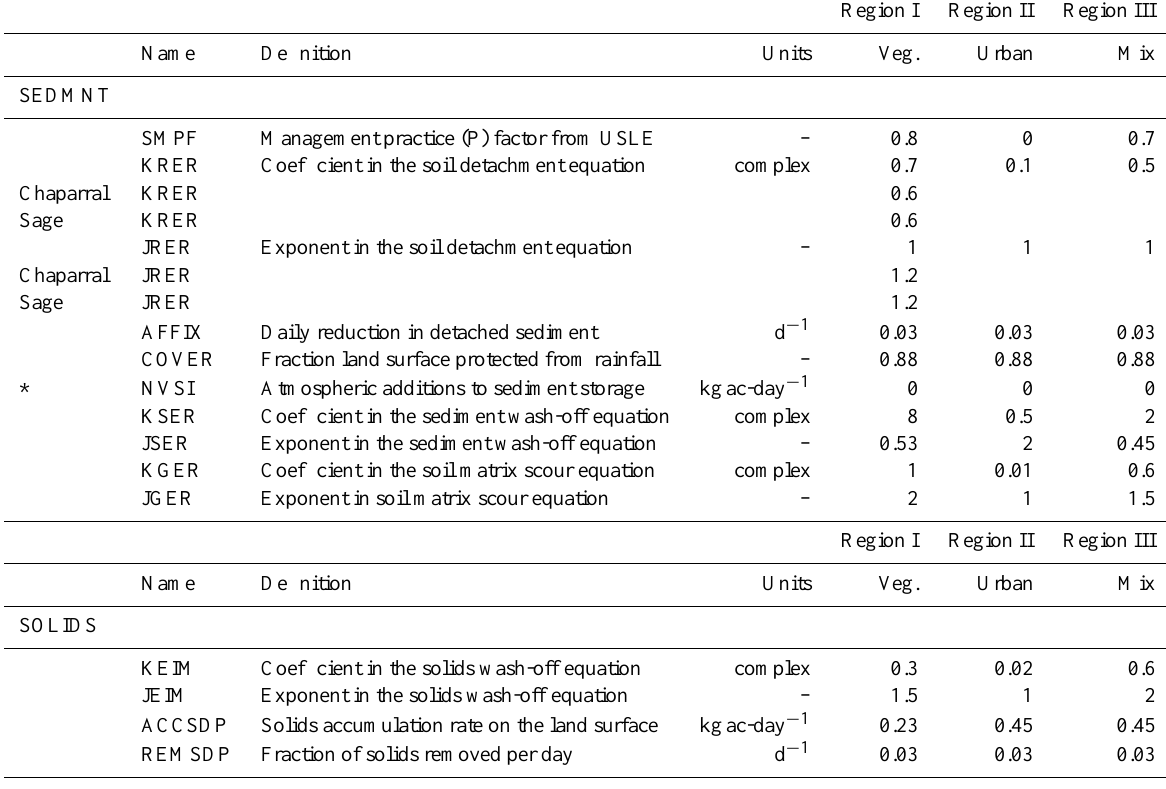
Table 3. Final model parameters used for sediment simulations in archetypal watersheds.